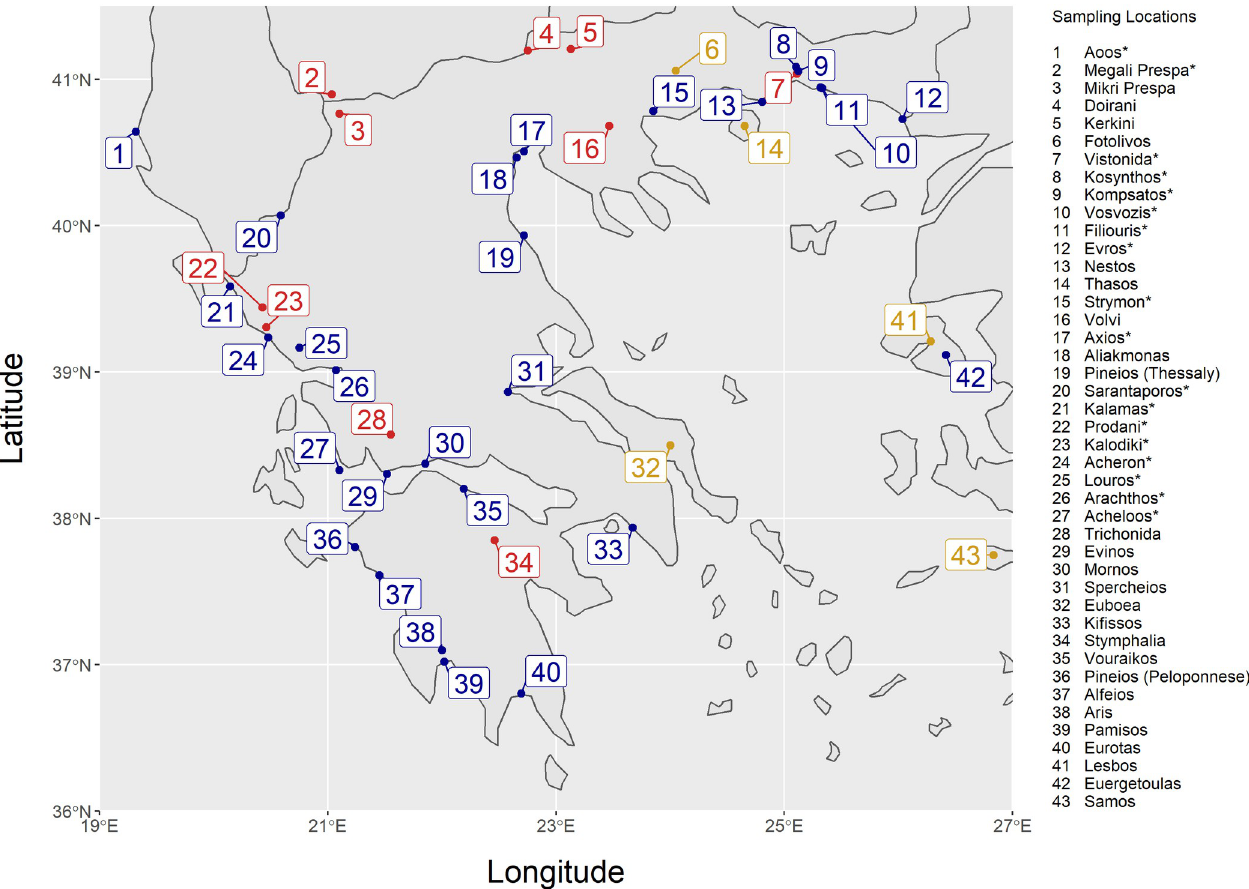
Fig 1. Map of sample origin areas. For the rivers, the location of the mouth is given. Rivers are marked with blue and lakes with red. A location marked with gold corresponds to the name of the broader sampling region and not a specific river or lake. The areas from which samples were gathered during the present study are marked with an